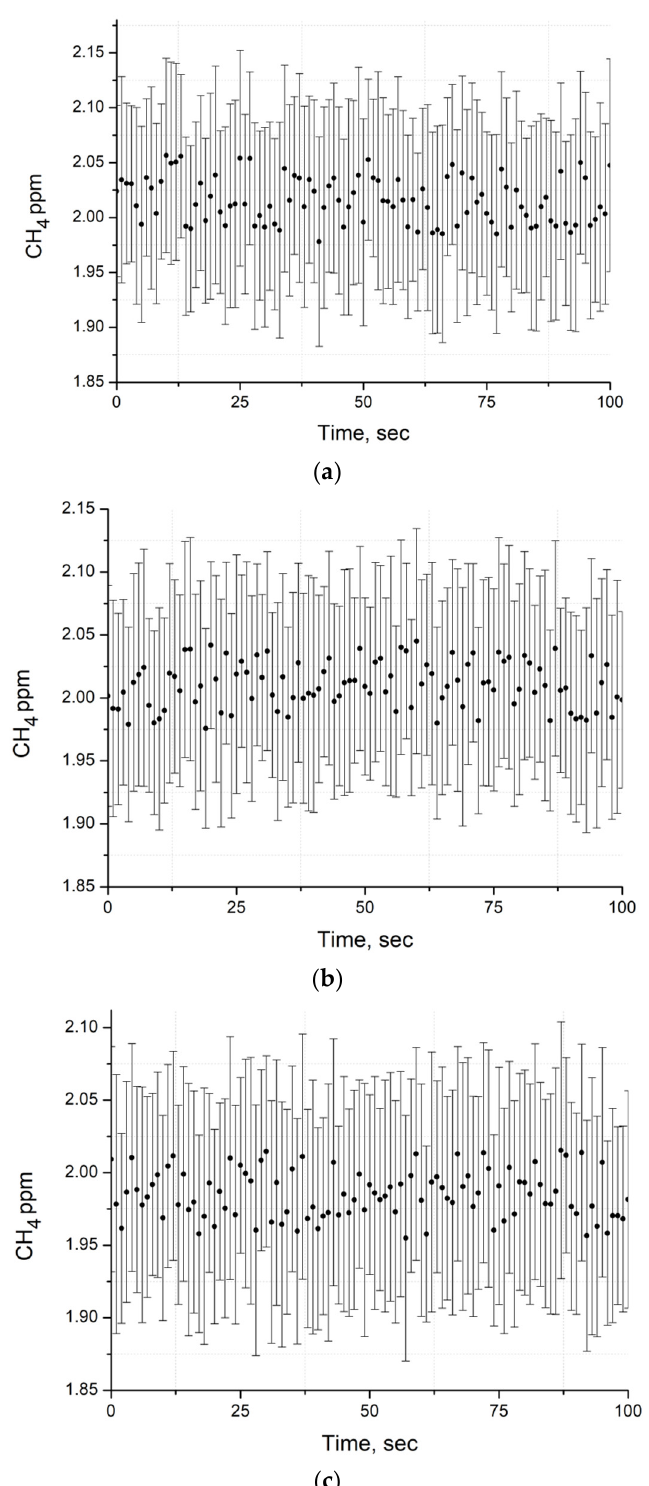
Figure 17. Average CH 4 concentration (black dots) reconstructed from lidar signals at informative wavelengths ( a ) under midlatitude summer conditions during an aircraft flight at an altitude of 2000–3000 m near Novosibirsk; ( b ) in Arctic summer conditions when the aircraft was flying at an altitude of 380 m above the coastal part near the Kara Sea; ( c ) conditions of the Arctic summer during the aircraft flight at an altitude of 270 m above the water area of the Kara Sea.